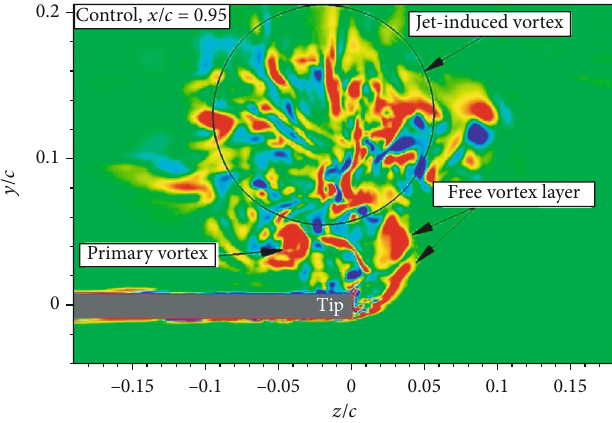
Figure 21: The instantaneous vorticity fi eld near the trailing edge under normal blowing.